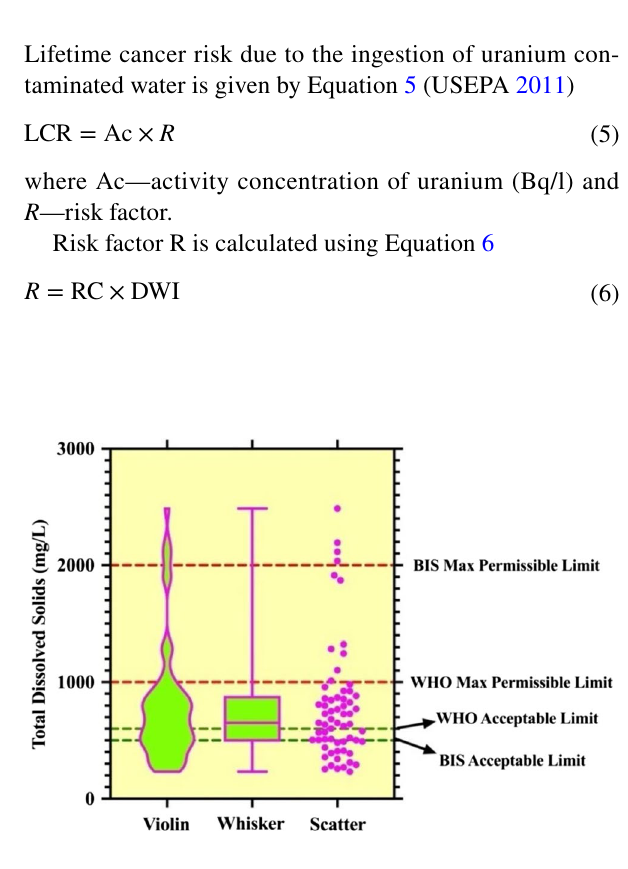
Fig. 9 Distribution of TDS in the